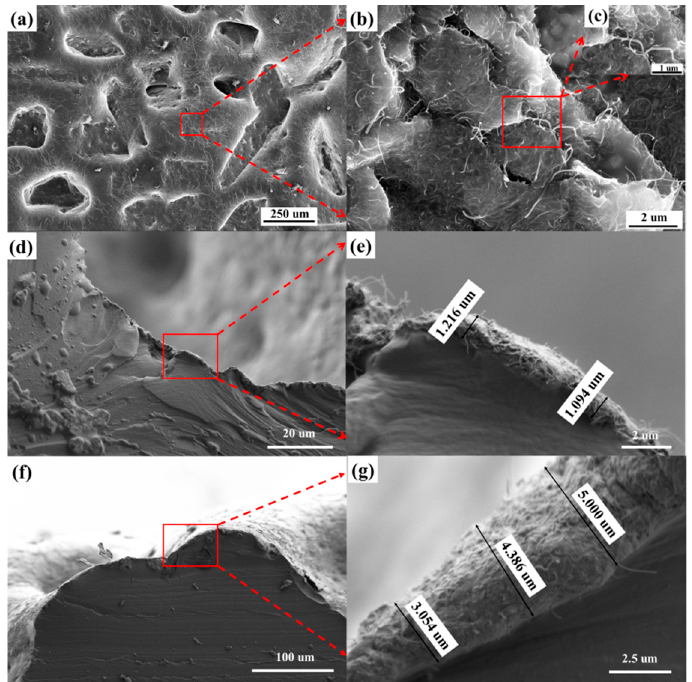
Figure 2. SEM image of the electrode layer. ( a ) The surface of electrode layer. ( b ) The MWCNTs layer. ( c ) Further amplification of the MWCNTs layer. ( d ) The cross-section of the bottom of the microstructure groove. ( e ) The thickness of the MWCNTs layer at the bottom of the microstructure groove. ( f ) The cross-section on the top of the microstructure bulge. ( g ) The thickness of the MWCNTs layer on the top of the microstructure bulge.